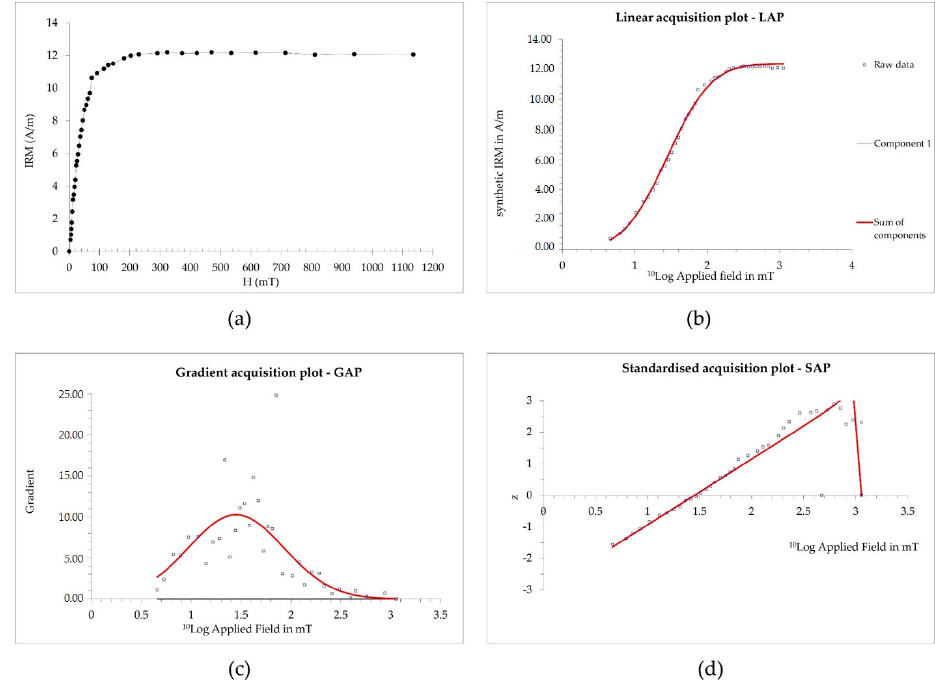
Figure 7. Analyses of ES87-C2 sample using the Kruiver et al. software [1]. ( a ) IRM acquisition curve